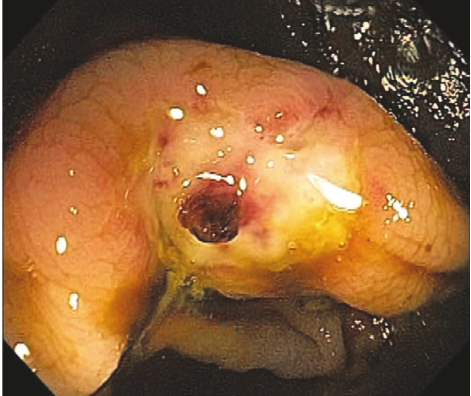
Figure 14: Endoscopic image of postpolypectomy cecal ulcer with a visible vessel.